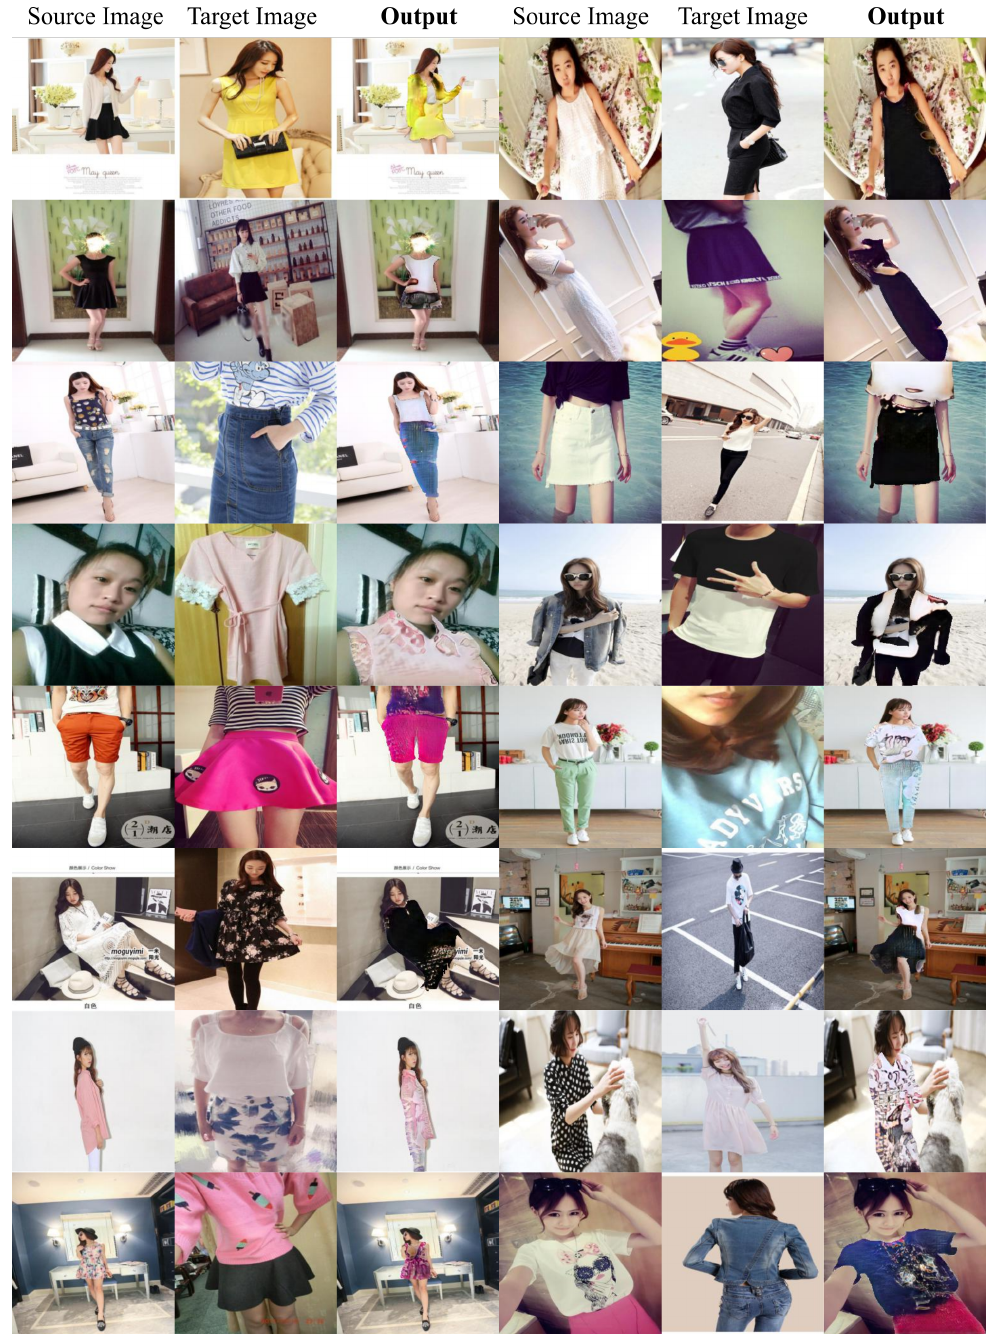
Figure 4. Some results with the proposed